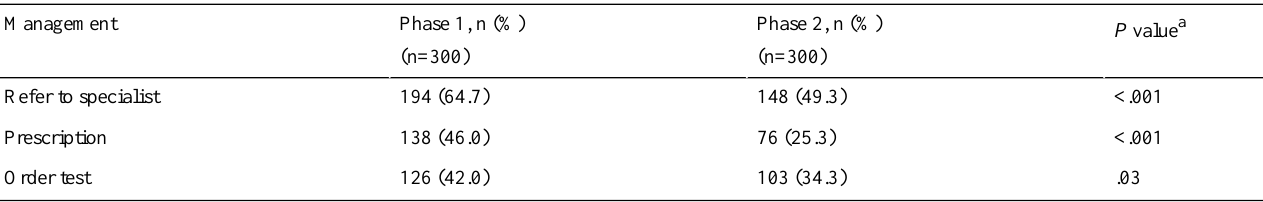
Table 6. Incorrect management by